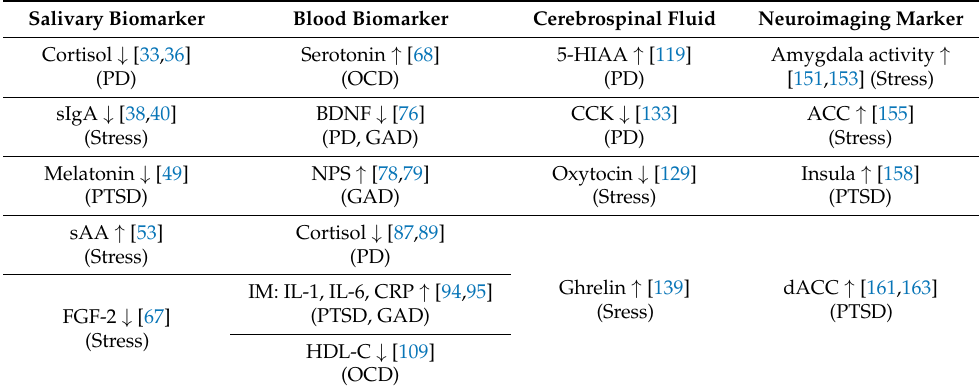
Table 1. Potential biomarkers of anxiety disorders and their